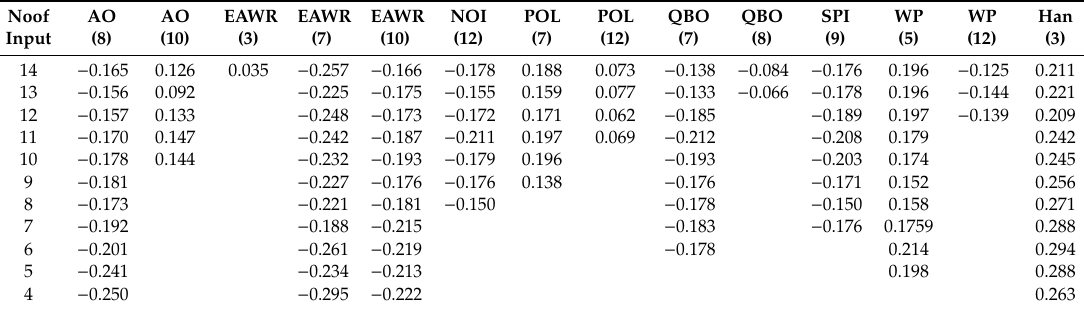
Table 3. Summary of the relative importance (RI) values of the input variables for the ANN-M models.